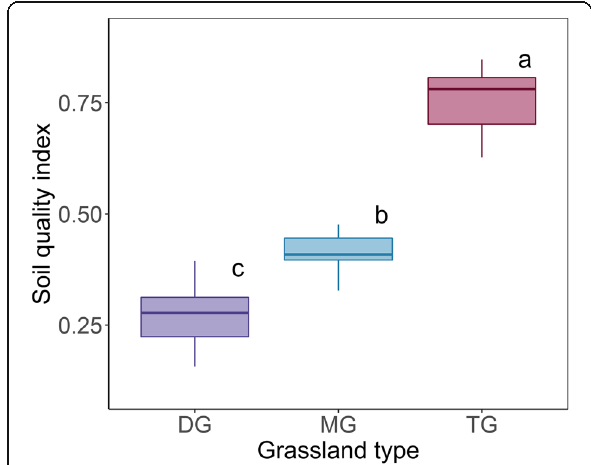
Fig. 1 Soil quality index across the grassland degradation gradient. DG, degraded grassland; MG, meadow steppe; TG, grassland from the forest-steppe ecotone. Bars with different letters indicate significant difference at P < 0.05. Error bars represent ± SE